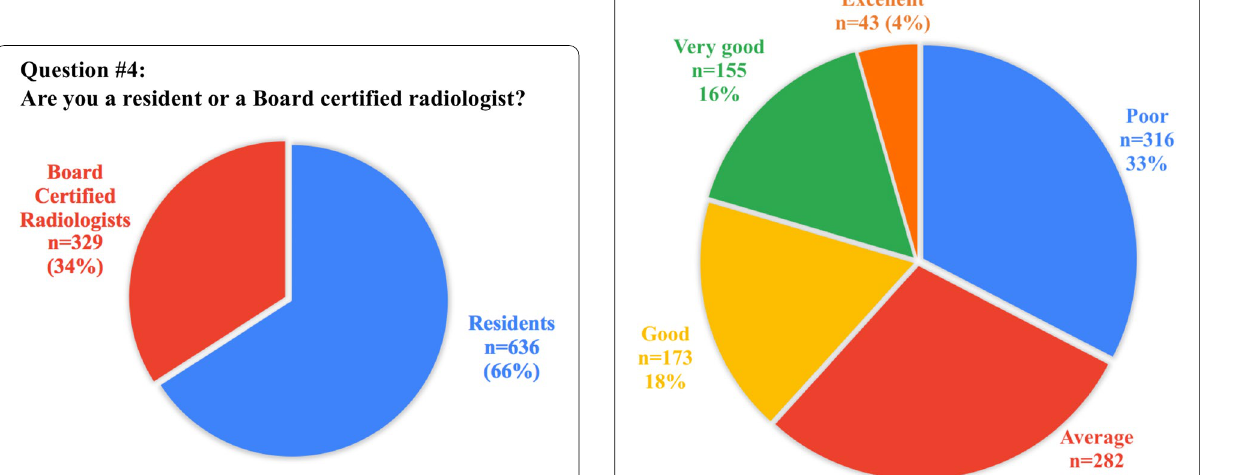
Fig. 1 Graphical representation of answer distribution to question #4: percentage of residents versus board-certified radiologists